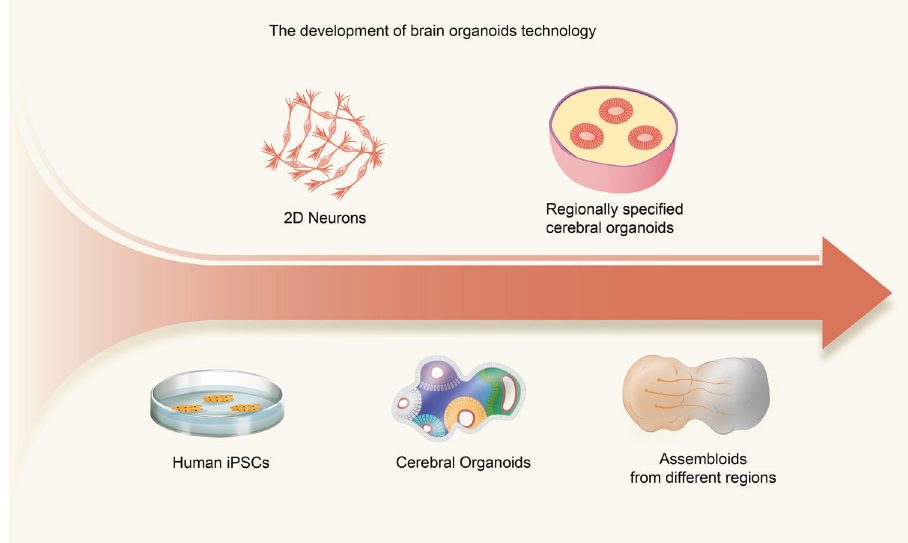
Fig. 3 Graphical summary of major milestones in the development of brain organoid technologies. The advent of human iPSC (hiPSC) technologies has enabled the production of specialized human cells in large quantities for disease modeling. hiPSCs have been widely available for 2D culture systems, but 3D models are regarded as more advanced alternatives to mimic human brain complexity. Lancaster et al. produced cerebral organoids by embedding embryoid bodies into an extracellular matrix (ECM), giving hiPSCs the most freedom for self- organization; the resulting organoids contained diverse tissues, including the retina, forebrain, midbrain, hindbrain, and choroid plexus. However, at the early stage of brain region-speci fi c organoid culture, patterning factors were used to determine the fate of progenitor cells and then removed at the further differentiation stages. These guided protocols allowed the generation of two or more organoids resembling various brain regions that can then be used to fuse to form assembloids, which can be used to simulate the interactions between